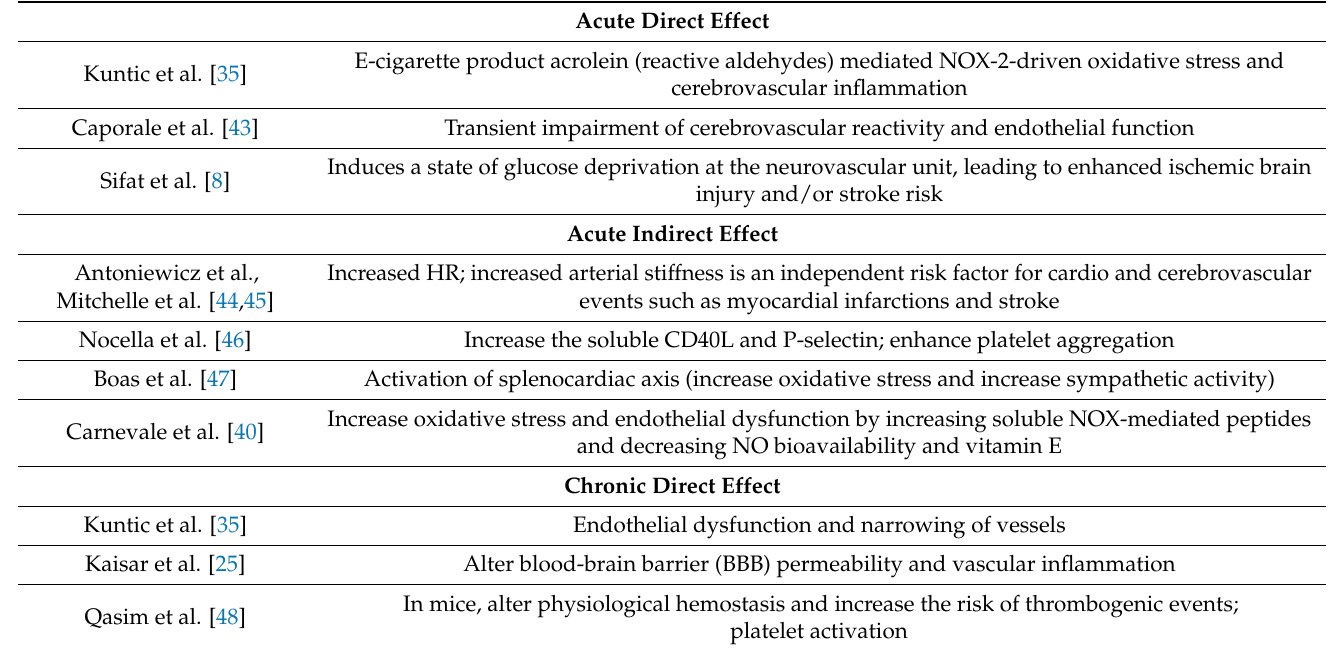
Table 5. Acute and chronic effects of e-cigarettes as a possible risk factor and trigger for